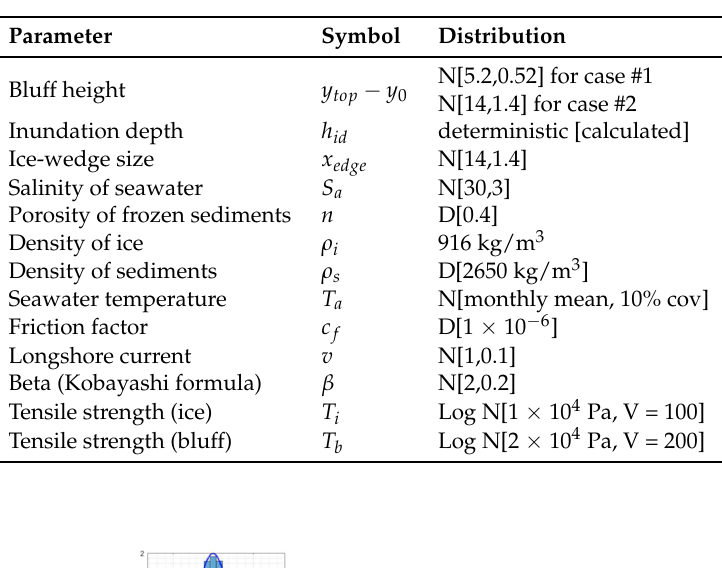
Table 3. Distributions of the input parameters for the numerical model. Here, N[x,y] = normal distribution with a mean of x and a standard deviation of y, D[z] = deterministic value of z and Log N[x,y] = lognormal distribution with a mean of x and a variance of y.